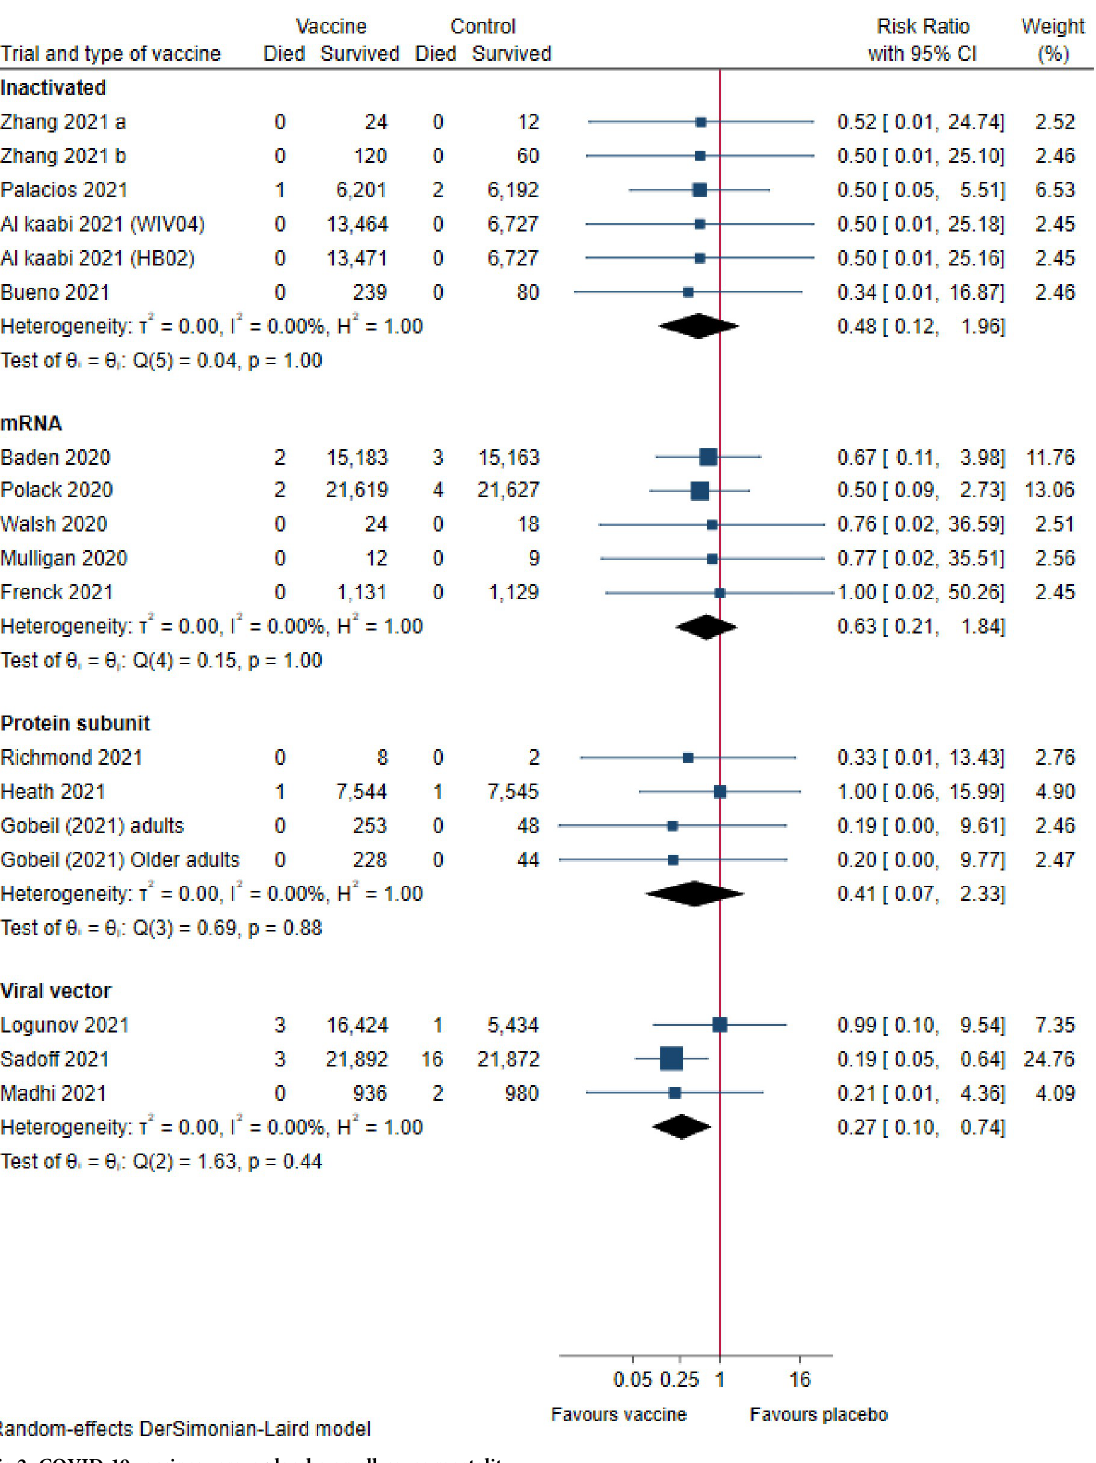
Fig 2. COVID-19 vaccines versus placebo on all-cause mortality.